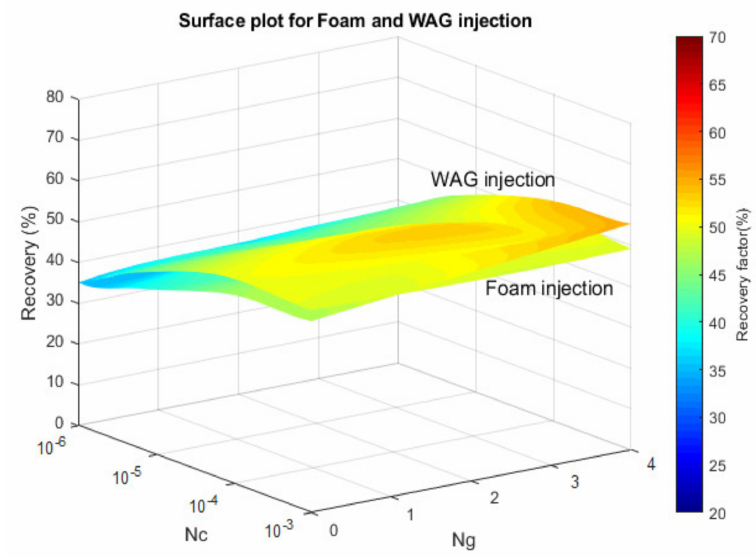
Figure 10. Surface plots of foam and WAG injection.